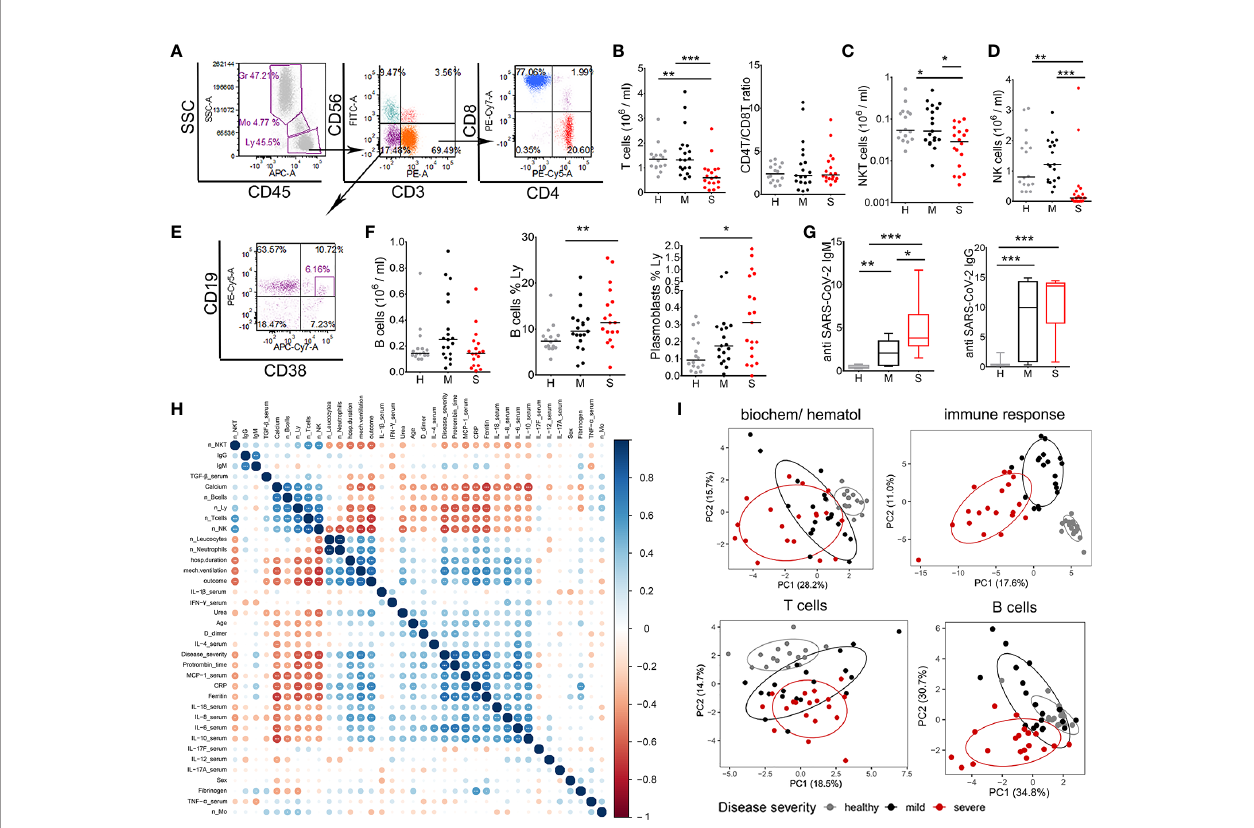
FIGURE 1 | Lymphocytes characterization and correlations with clinical parameters of coronavirus disease (COVID)-19. (A) Representative gating of lymphocyte populations is shown. Doublets were excluded by FSc-A/FSc-H (not shown) and lymphocytes (Ly) (CD45 hi SSc low ) were gated to identify NKT (CD3 + CD56 + ), NK (CD3 - CD56 + ), and T (CD3 + CD56 - ) cells. T cells were gated to identify CD4 and CD8 T cell subsets. (B) The number of T cells/ml was calculated from the percentage of cells and the number of leukocytes for each donor in the groups of healthy donors (H, n=16), mild (M, n=19) and severe (S, n=19) patients. CD4/CD8 T cell ratio was calculated from the percentage of CD4 + and CD8 + T cells in lymphocytes region. The numbers of NKT (C) and NK cells (D) were calculated as in (B) . (E) B cells (CD19 + ) and plasmablasts (CD19 + CD38 hi ) were gated from CD3 - CD56 - region as indicated. (F) The number of B cells/ml, the relative percentage of B cells and plasmablasts in lymphocytes region are shown. (G) The levels of SARS-CoV-2-speci fi c IgM and IgG antibodies in sera of patients (mild n=21, severe n=20) and healthy donors (n=16) are shown as Tukey box-whiskers. (B, D, F, G) *p < 0.05, **p < 0.01, ***p < 0.005 as indicated (Kruskal-Wallis test with Dunn ’ s post-test). (H) Spearman ’ s correlation matrix and hierarchical clustering of 36 common features in 19 mild and 19 severe COVID-19 patients. The color and size of the circles represent the correlation coef fi cient. Asterisks indicate signi fi cance levels for each comparison, at FDR below 0.05 (*), 0.01 (**), and 0.001 (***). n_, number; Mo- monocytes. (I) Principal component analysis (PCA) of hematological and biochemical (n=17), immune response (n=144), T cells (n=35), B cells and antibody data (n=11) are shown with 95% con fi dence ellipse for healthy donors, mild, and severe COVID-19